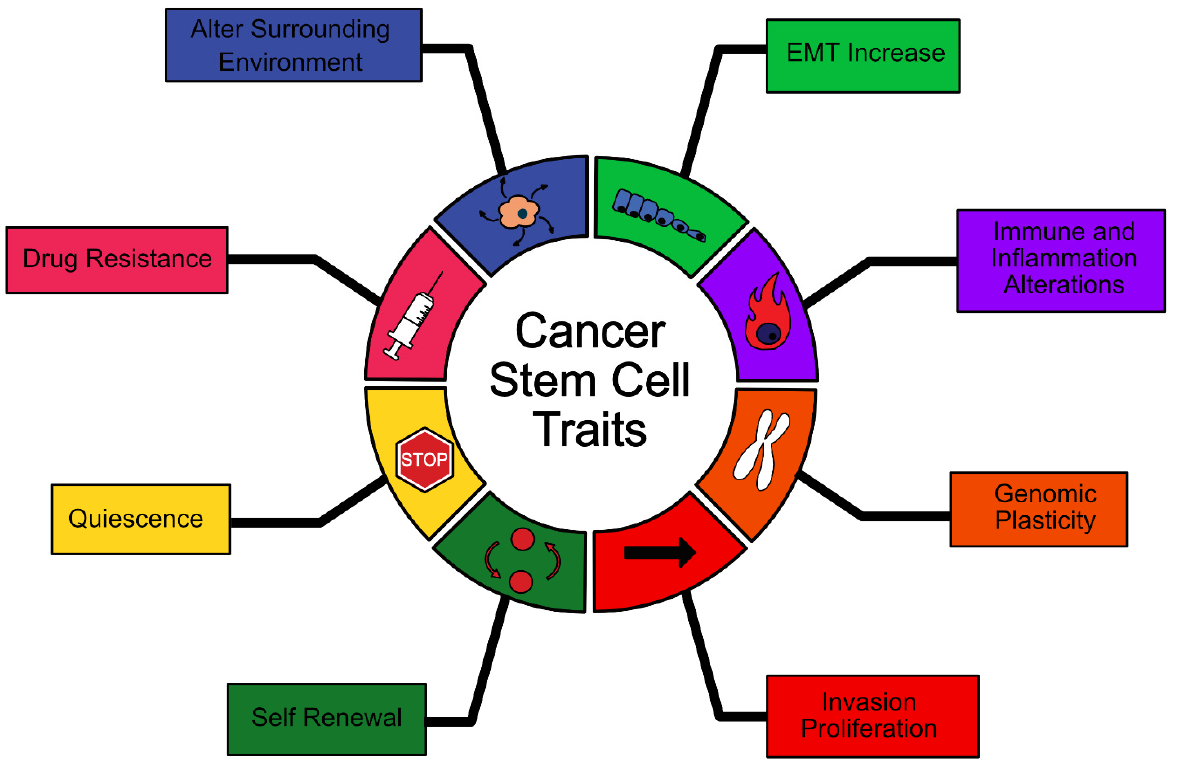
Figure 1. Summary of cancer stem cell traits.